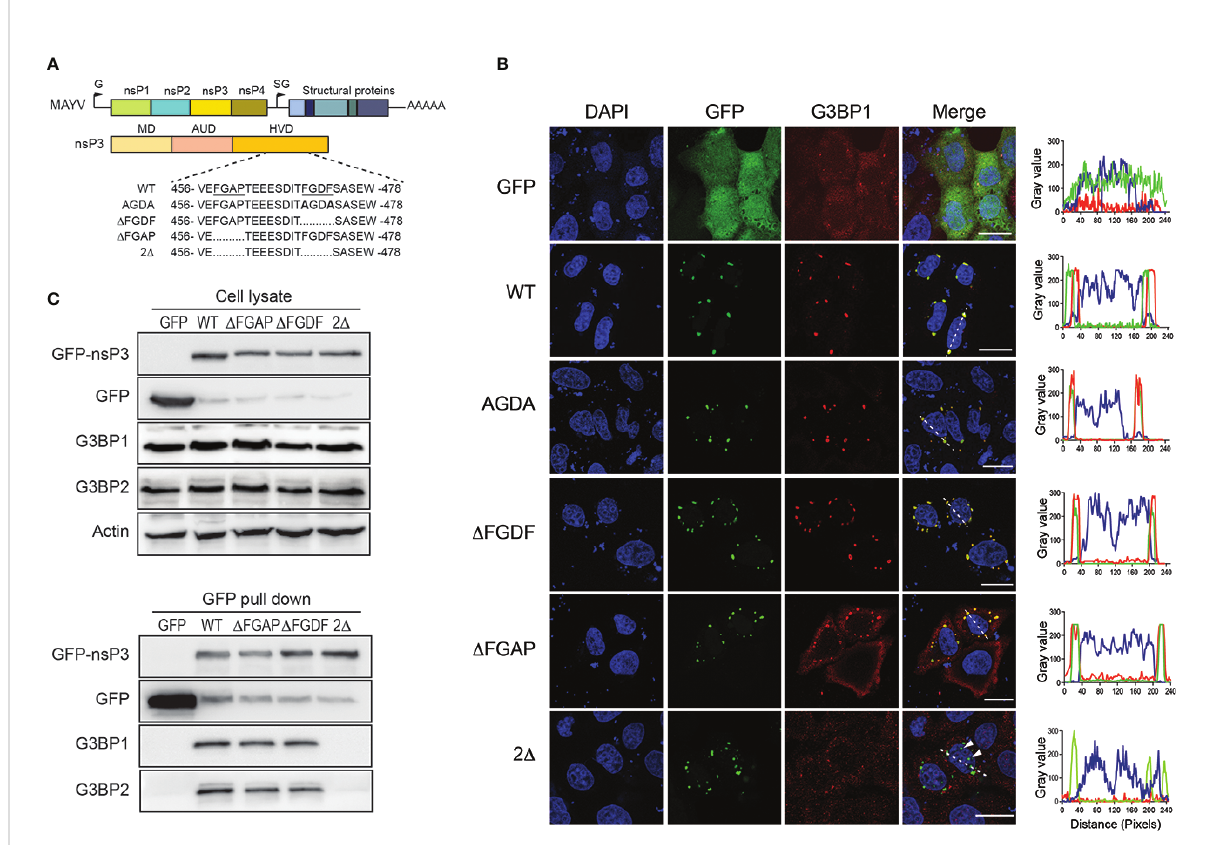
FIGURE 6 FGAP and FGDF sequences in MAYV nsP3 HVD are required for G3BP1 colocalization and binding. (A) Schematic representation of the MAYV genome, nsP3 organization, and deletion mutants in nsP3 HVD. The sequence of wild-type (WT) nsP3 with underlined FGAP and FGDF sequences is shown (top). Sequence and deleted amino acids in AGDA, D FGDF, D FGAP, and 2 D mutants are represented. The numbers indicate the amino acid positions in the MAYV nsP3 sequence. (B) HeLa cells were transfected for 24 h with plasmids encoding GFP-nsP3 proteins depicted in (A) . The cells were labeled with anti-G3BP1 antibodies, and nuclei were stained with DAPI. An orthogonal fl uorescence pro fi le corresponding to the white line is shown for each panel. Bars, 20 µm. (C) Cell lysates prepared from (B) were pulled down using GFP- Trap. Total cell extracts (upper panel) and trapped complexes (lower panel) were separated on an SDS-PAGE and probed with antibodies against GFP, G3BP1, and G3BP2. Equivalent protein content in cell lysates was controlled using actin antiserum. Results are representative of two distinct